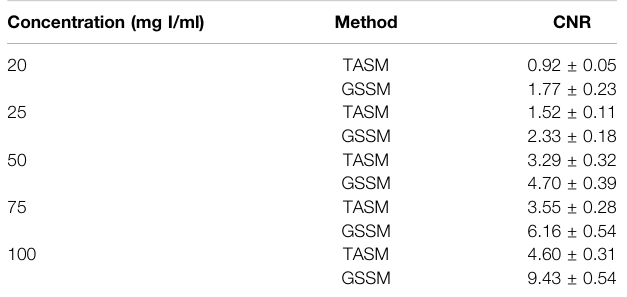
TABLE 3 | CNR comparison of decomposition images of TASM and GSSM.